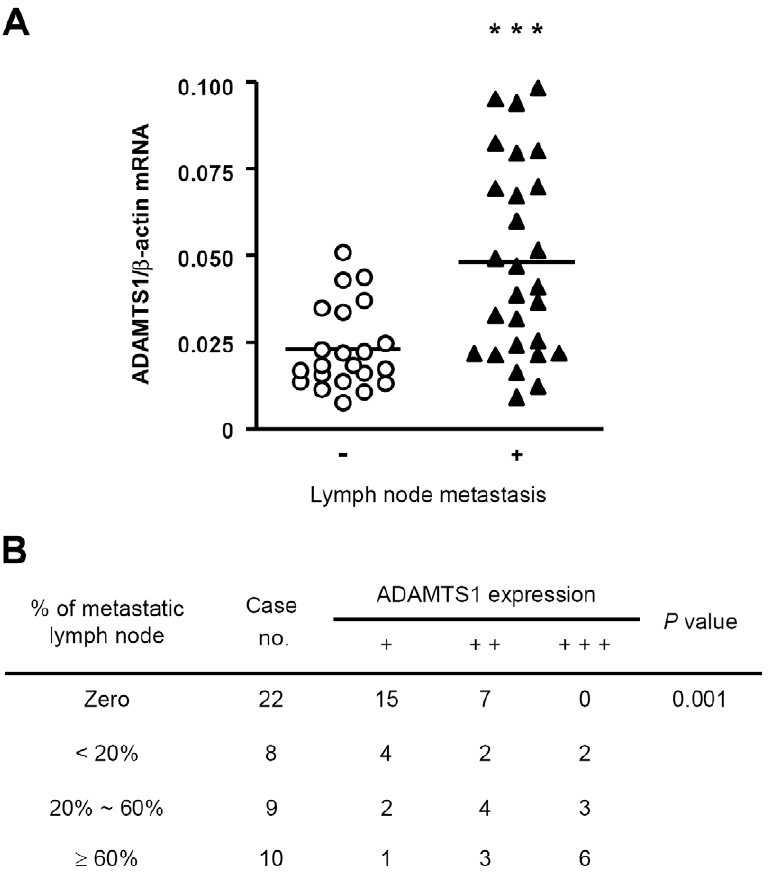
Figure 4. ADAMTS1 expression in CAF correlated with lymph node metastasis. (A) A scatter dot plot of ADAMTS1 mRNA levels in CAFs assessed using quantitative real-time RT-PCR analysis. The ADAMTS1 mRNA levels in CAFs of patients with lymph node metastasis (n=27) were significantly higher than in those of patients without lymph node metastasis (n=22) (P=0.0003). Data are shown as mean 6 SD of triplicate samples. Statistical significance was evaluated by Student’s t-test. *** P , 0.001. (B) The relationship between ADAMTS1 expression and lymph node metastasis was analyzed using Fisher’s exact test. ADAMTS1 expression levels in CAFs derived from patients with $ 60% lymph node metastasis were significantly higher than those of patients with # 60% lymph node metastasis or with zero lymph node metastasis ( P =0.001). Relative quantity (RQ) of ADAMTS1 expression compared to beta-actin expression: + , 0.001 # RQ # 0.025; ++ , 0.025 , RQ , 0.051; +++ , RQ $ 0.051.